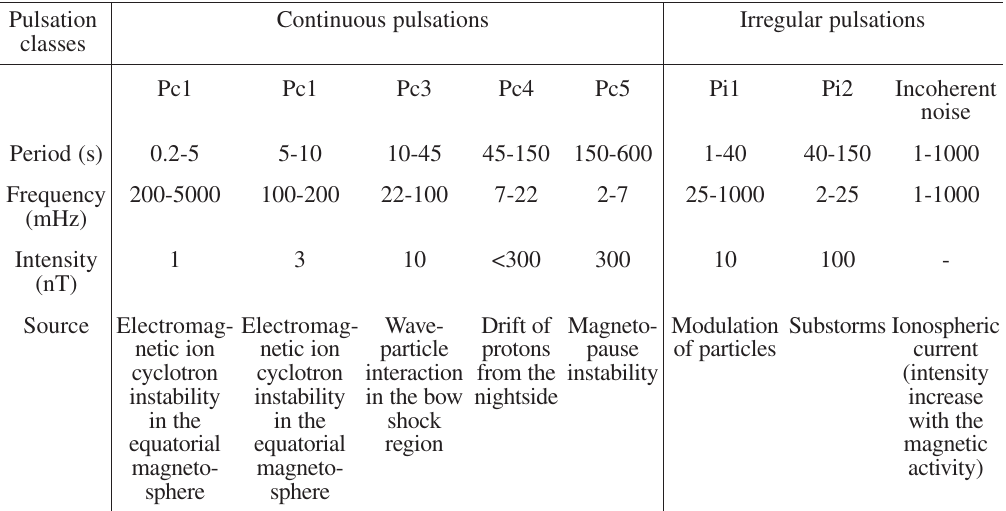
Table II. Magnetic noise sources in the pulsation band. Pulsation